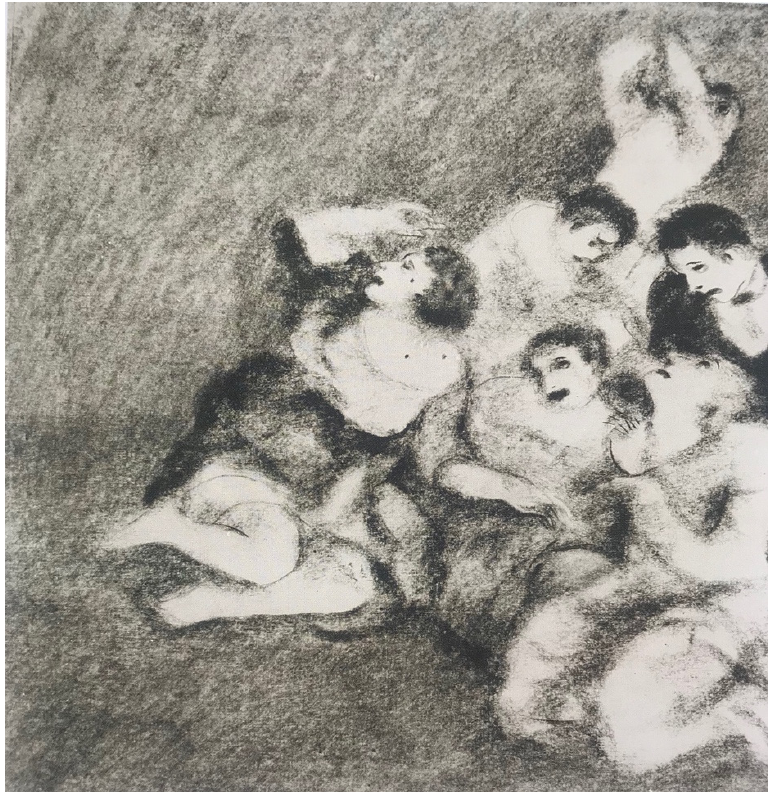
Figure 2. Vasily Chekrygin, From the Execution by Shooting series , 1920, pencil and charcoal on paper, State Tretyakov Gallery, Moscow.